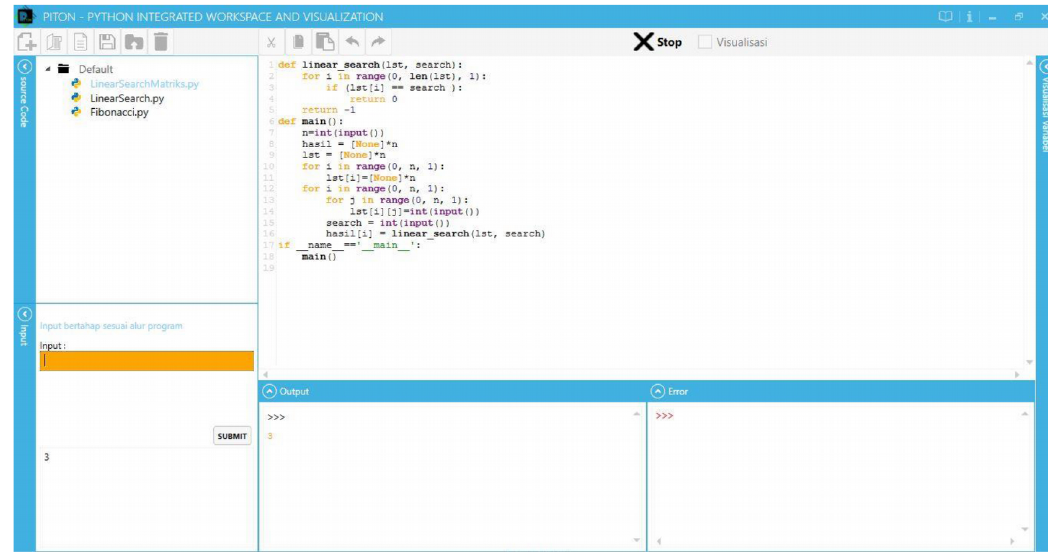
Figure 4. The user interface of PITON while running displayed source code without